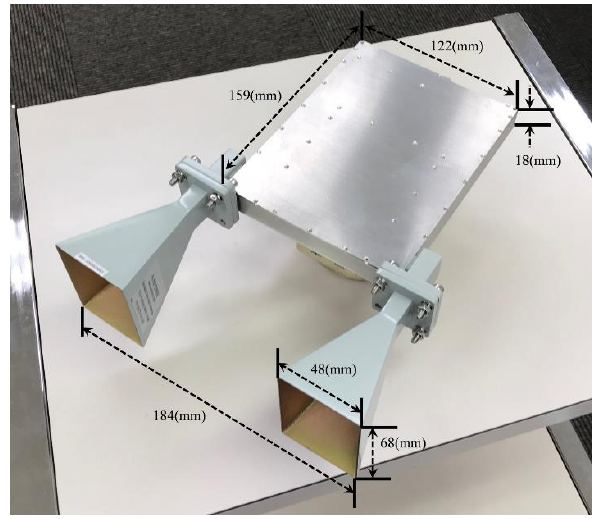
Figure 3. Appearance of drone-borne radar